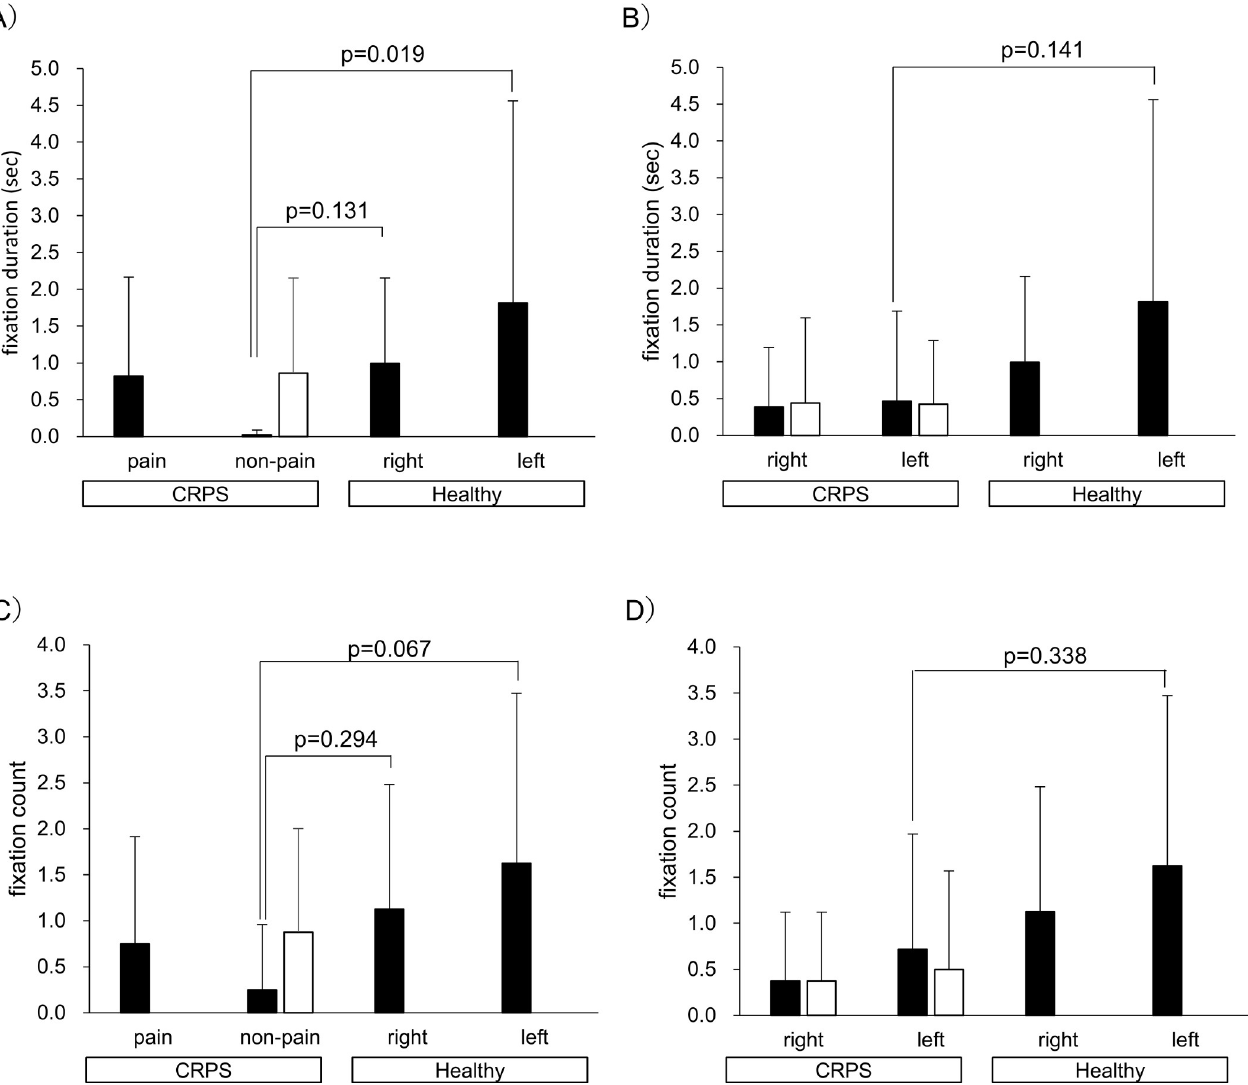
Fig 5. Fixation duration and count while watching video clip 2: Comparison within the touch side or contralateral side. A) Fixation duration: Comparison of painful and non-painful side hands in CRPS patients, left and right hands in healthy controls. B) Fixation duration: Comparison of left and right hands in CRPS patients and healthy controls. C) Fixation count: Comparison of painful and non-painful side hands in CRPS patients, left and right hands in healthy controls. D) Fixation count: Comparison of left and right hands in CRPS patients and healthy controls. Value: mean and standard deviation. ■ : touched side, □ : contralateral side. CRPS: complex regional pain